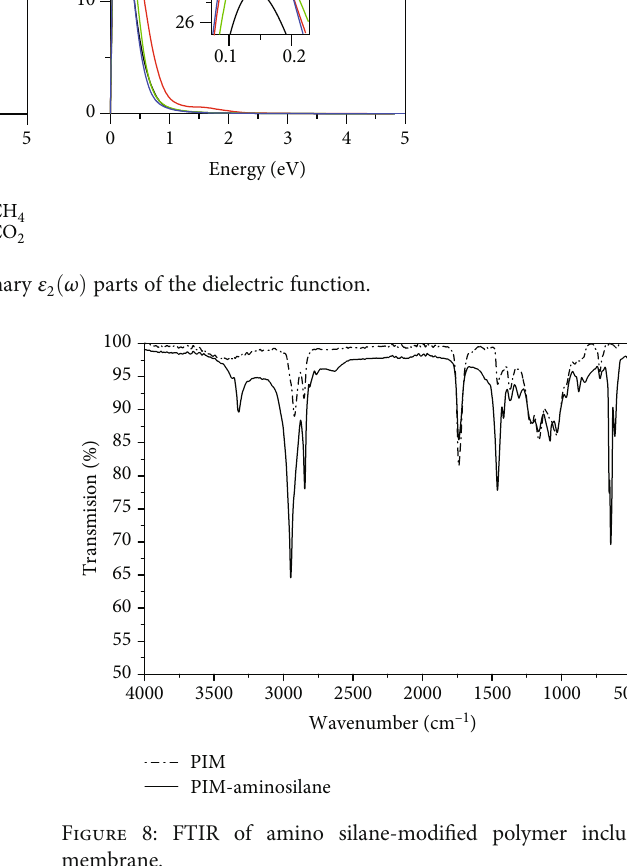
Figure 8: FTIR of amino silane-modi fi ed polymer inclusion